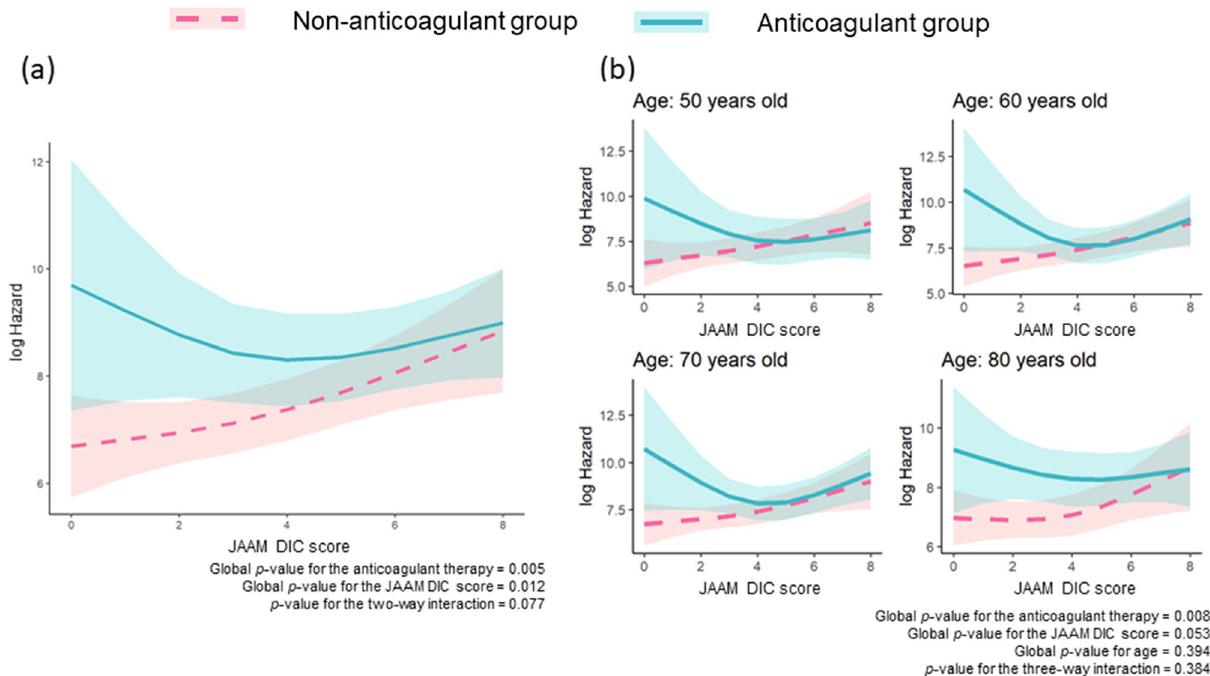
Figure 4. Regression lines of the SOFA score 72 h after admission in each treatment group. ( a ) Two-way interaction term between the treatment and JAAM DIC score. ( b ) Three-way interaction term among anticoagulant therapy, JAAM DIC score, and age. The lines indicate estimated log-transformed relative hazards, and the shaded areas represent 95% confidence intervals. The solid blue line represents patients in the anticoagulant group, and the dotted red line represents those in the non-anticoagulant group. Anticoagulant therapy was defined as the administration of antithrombin, recombinant human thrombomodulin, or